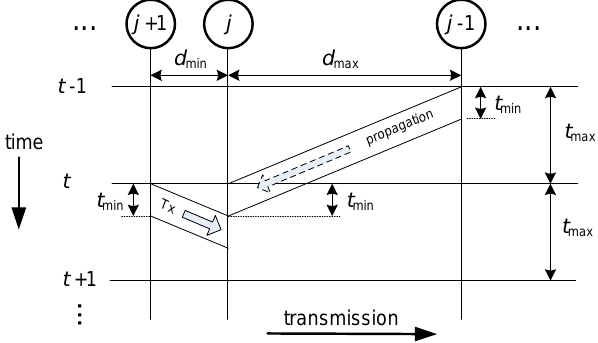
Figure 7. To illustrate the general case of unequally spaced nodes in the event of adjacent shortest and longest links.